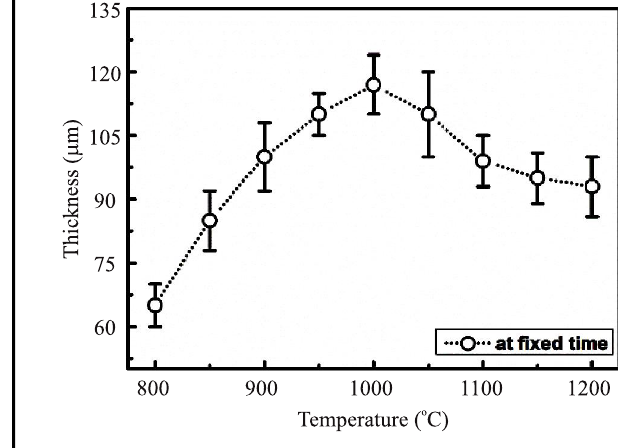
FIG. 3. THE DATA THAT WAS OBTAINED AT DIFFERENT TEMPERATURES TO MEASURE THE